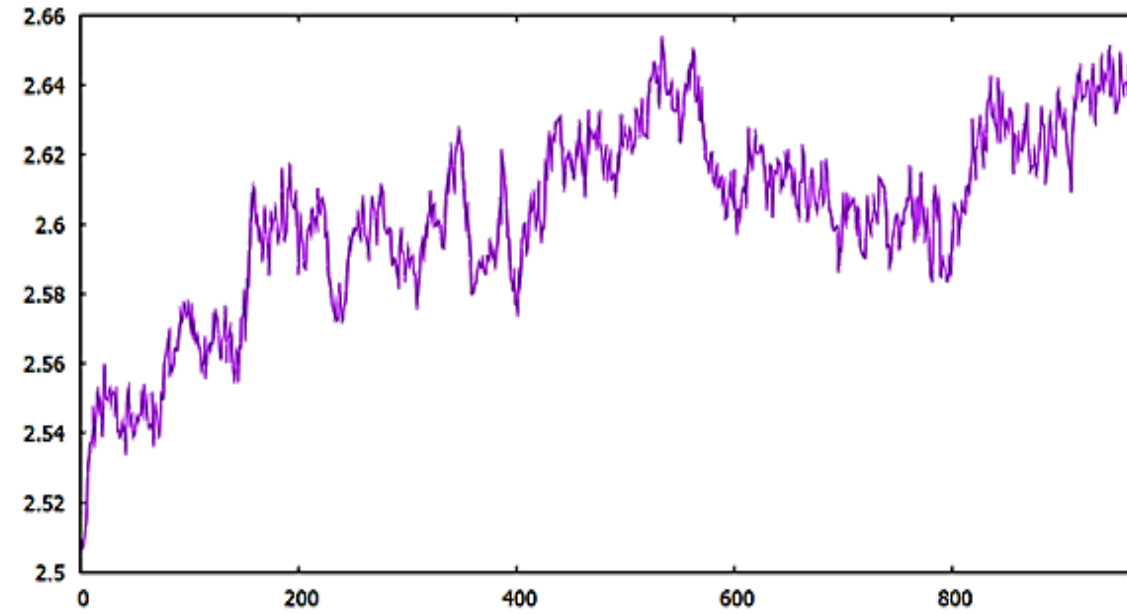
FIGURE 4 - Gyration plot of DENV4-NS1 at 300K.